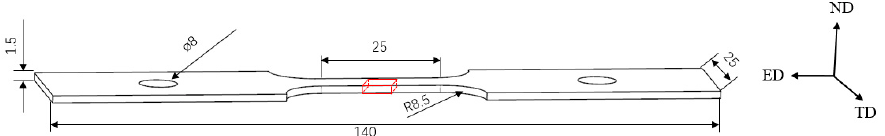
Figure 1. Geometry of the specimen used for the hot tensile test (unit: mm); ED: extrusion direction, TD: transverse direction; ND: normal direction.